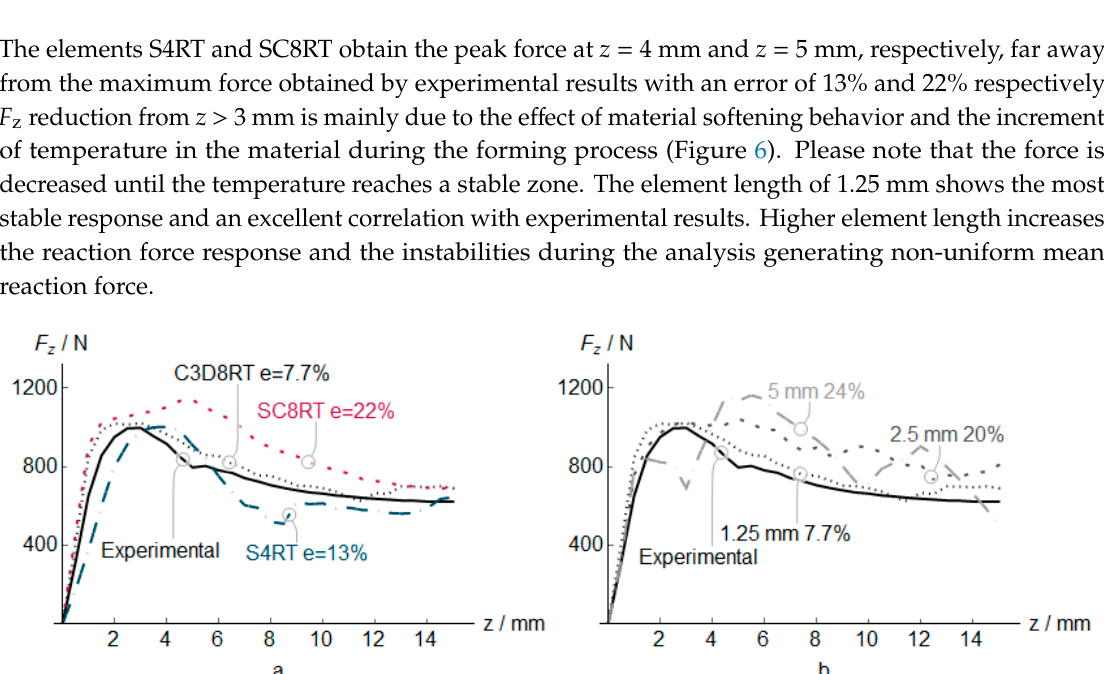
Figure 5. Plane force F xy in PVC incremental forming. Experimental vs. predicted mean values at z positions, and estimation error e for different elements ( a ), and different C3D8RT sizes ( b ).